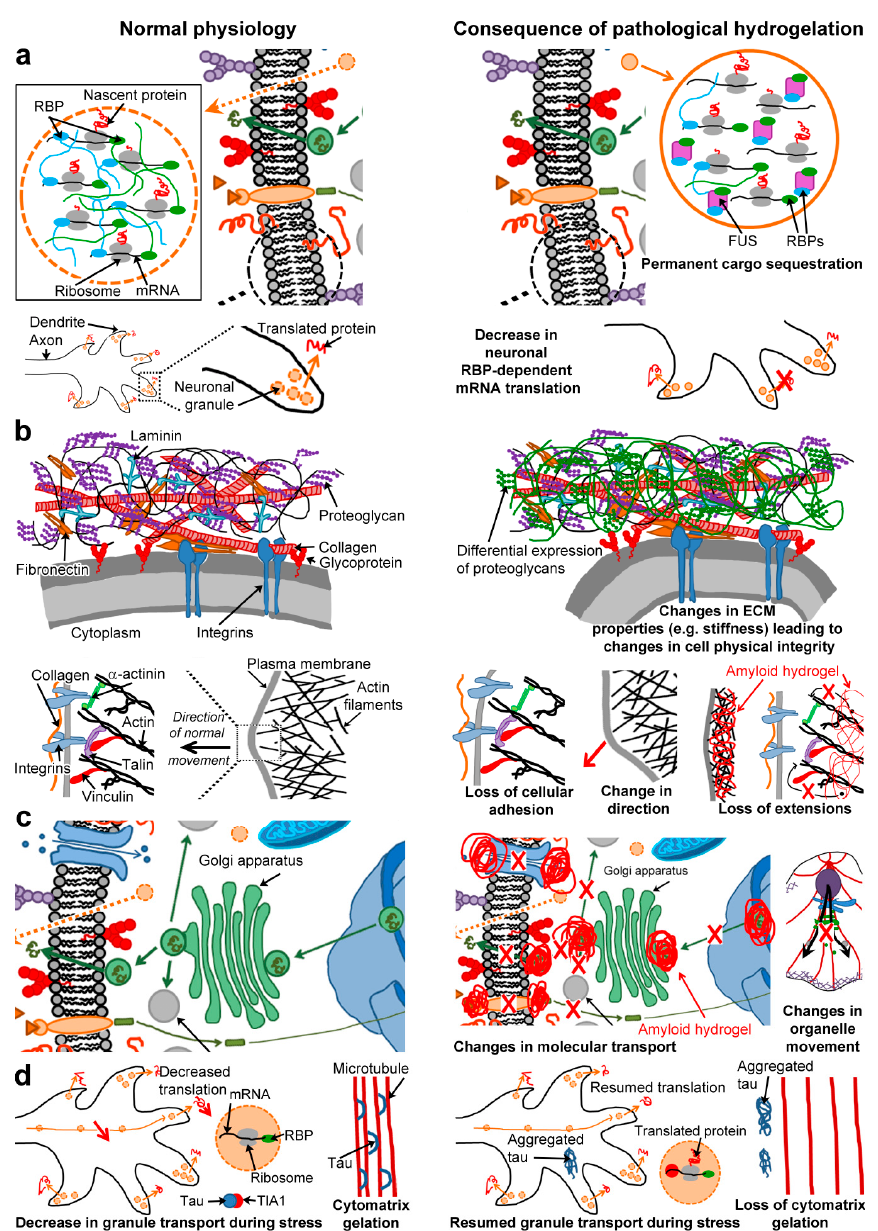
Figure 3. Consequences of hydrogelation by pathological amyloid-forming polypeptides on normal cellular functions. ( a ) Permanent cargo sequestration ( top panels ) and decrease of RNA-binding protein (RBP)-dependent translation of mRNA ( bottom panels ). In normal physiology, cargos are transiently sequestered within granules due to reversible hydrogelation, and are released from them by gel melting ( left top panel ). In neurons, neuronal granules trap, via RBPs, mRNA encoding proteins in close proximity to synapses ( bottom left panel ). In the disease state, pathological amyloid-forming polypeptides, such as fused in sarcoma (FUS), can permanently trap cargo (e.g., RBPs) by forming an irreversible hydrogel ( right top panel ). This permanent cargo trapping can affect granule function